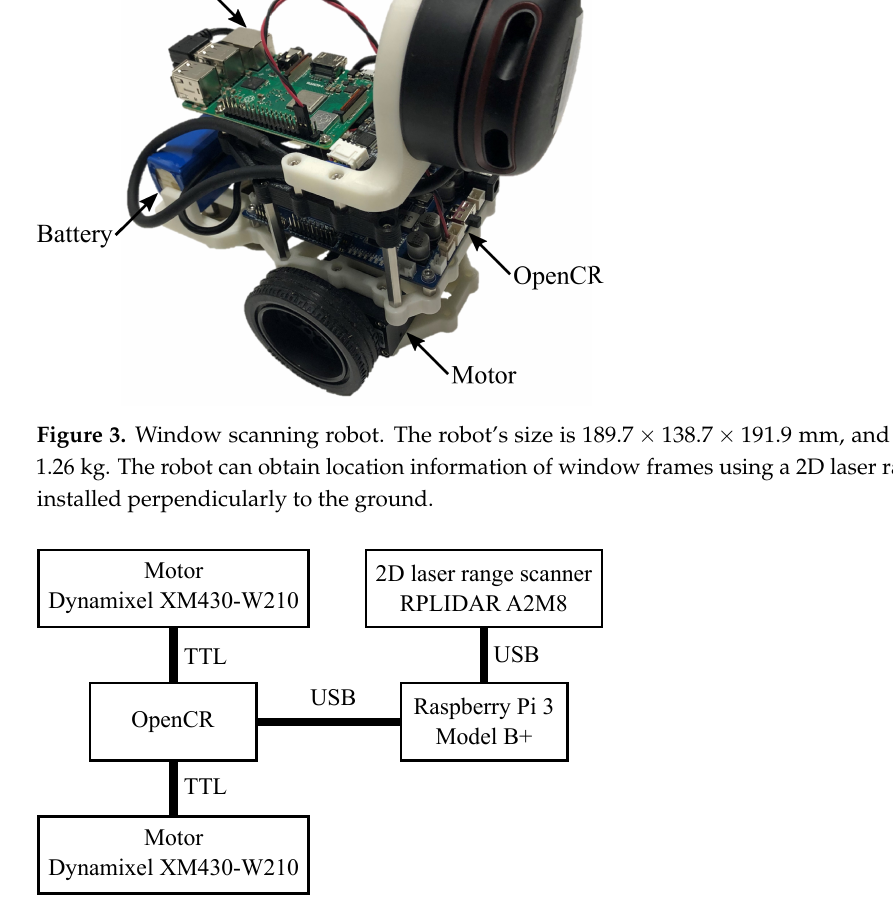
Figure 4. System architecture of the window scanning robot. The system is developed on the basis of the architecture of TurtleBot3 and consists of Raspberry Pi 3 Model B+, OpenCR, the RPLIDAR